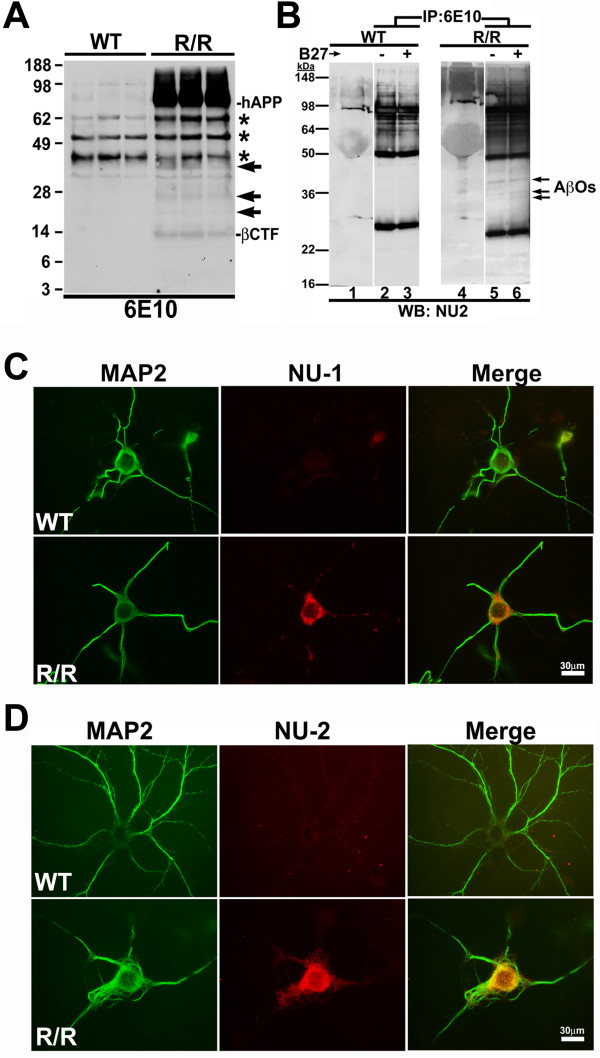
Presence of cell-associated and secreted oligomeric Aβ assemblies in primary neurons from the R1.40 transgenic mouse model of AD. A. Western blot analysis of detergent soluble cell extracts of from cultured primary cortical neurons (21 DIV) from non-transgenic (WT) and homozygous R1.40 (R/R) mice revealed the presence of numerous bands migrating between 14 and 38 kDa (arrows) that were immunoreactive with antibody 6E10 (recognizing residues 1–17 of Aβ1–42 peptide) in the R/R samples but not WT samples. Each lane for WT and R/R cultures represents extracts from three independent cultures. hAPP = holo APP; βCTF = β C-terminal fragment. Asterisk denotes the presence of non-specific bands detected with the human-specific 6E10 antibody. B. Primary cortical neurons (21 DIV) from WT and R/R mice were prepared and grown for 24 h in the presence of fresh NB media with (+) or without (-) the B27 serum supplement. Immunoprecipitatation of conditioned media with antibody 6E10, followed by Western blot analysis with the anti-Aβ oligomer specific antibody, NU-2 revealed the presence of multiple NU-2 reactive bands between 30–40 kDa (arrows) that were present in the R/R (lanes 5 and 6), but not WT (lanes 2 and 3) samples. Lanes 1 and 4 shows total input lysates. C-D. Aβ oligomers are secreted by R/R neurons. Cultured primary cortical neurons (21 DIV) from wild-type (WT) and homozygous R1.40 (R/R) embryos were double labeled with MAP2 (green in C and D) or Aβ oligomer specific antibodies NU-1 (red in C) or NU-2 (red in D). Merged images are shown in right panel. NU-1 and NU-2 immunreactivities were specifically observed in R/R, but not WT, neurons. Scale bar 30 μm.